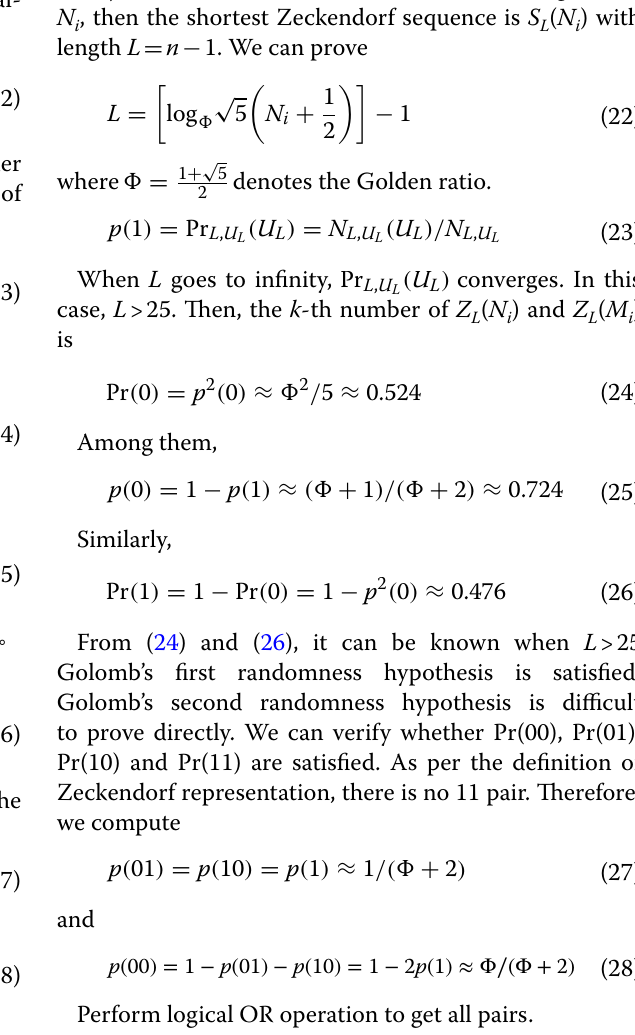
Algorithm implementation Based on the characteristics of the Zeckendorf represen- tation structure, a pseudo-random key stream generation algorithm is